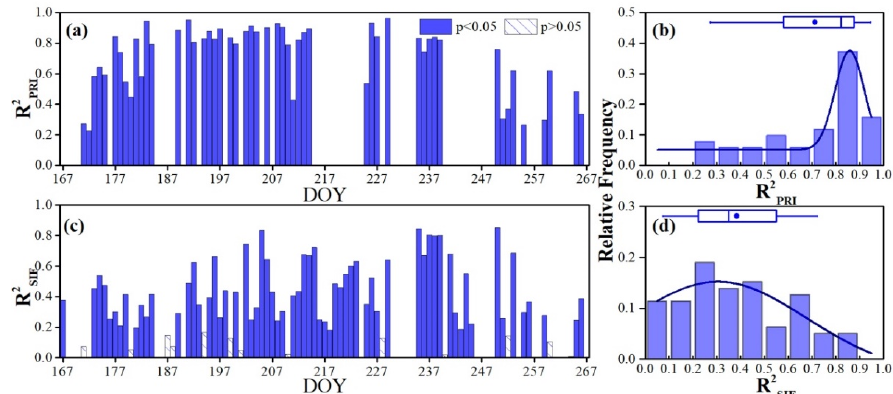
Figure 4. Coefficients of determination between LUE PRI ×APAR and GPP EC (R 2PRI ), SIF can and GPP EC (R 2SIF ) on individual days and distribution of their relative frequency over the 2018 growing season of the maize field. ( a ) and ( b ) represented the R 2PRI and its relative frequency respectively, while ( c ) and ( d ) represented the R 2 SIF and its relative frequency respectively.